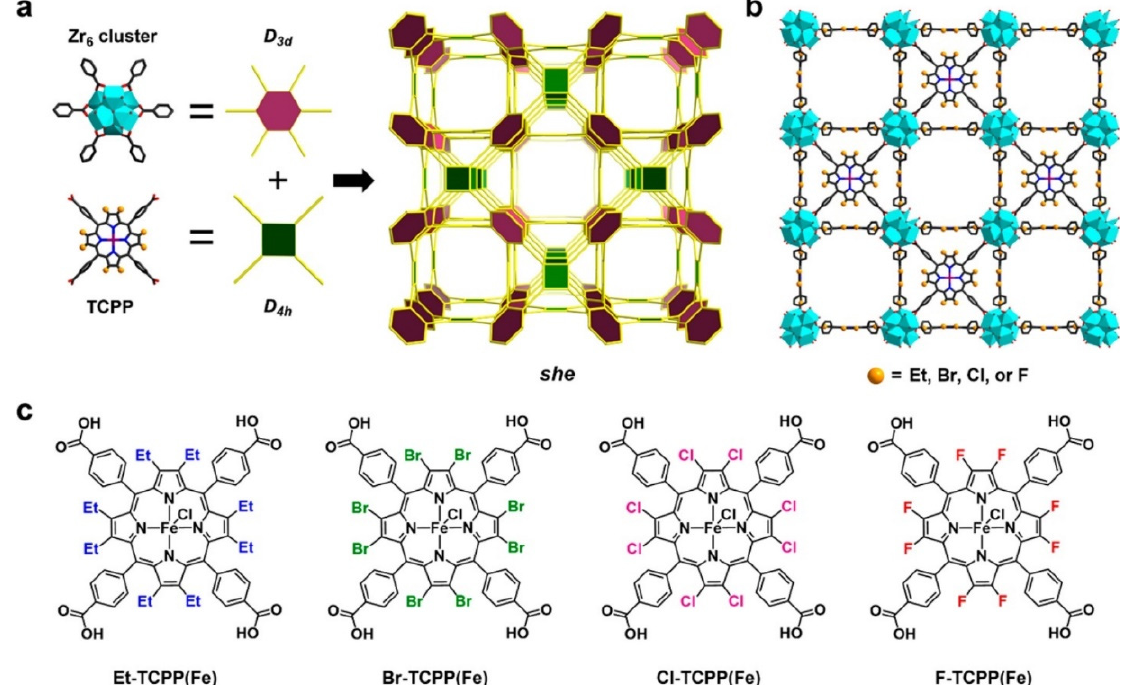
Figure 2. ( a ) Assembly of D 3d and D 4h nodes into (4,6)-connected she topological network. The Zr 6 cluster and TCPP(Fe) ligand can be viewed as 6- and 4-connected nodes, respectively. ( b ) View down the tetragonal channels of R-PCN-224(Fe) (black, carbon; purple, iron; blue, nitrogen; hydrogen and chloride, omitted). The yellow spheres represent Et, Br, Cl, or F. ( c ) Chemical structures of Et-TCPP(Fe), Br-TCPP(Fe), Cl-TCPP(Fe), and F-TCPP(Fe) linkers. Adapted with permission from [29]; Published by American Chemical Society, 2017.